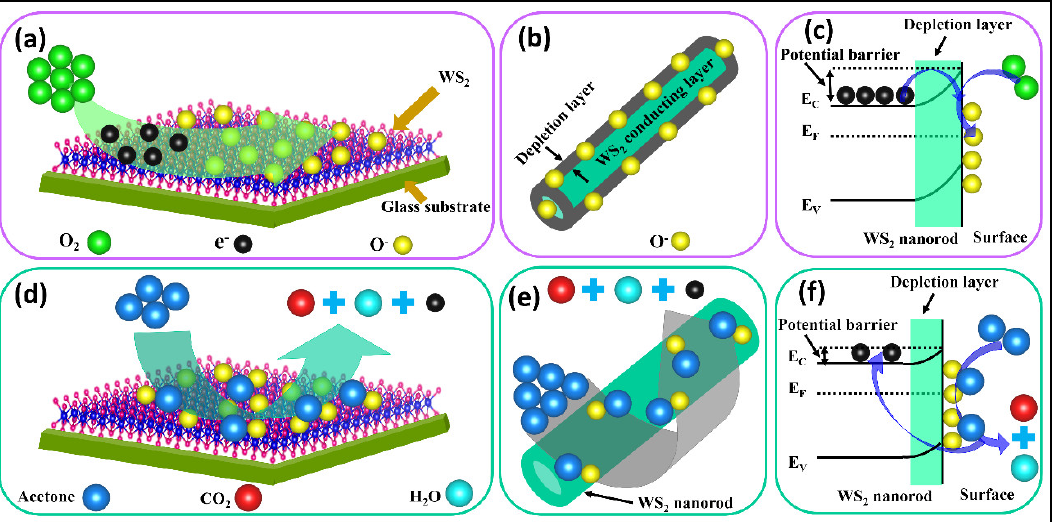
Figure 8. WS 2 nanorod sensor: ( a , d ) Graphical illustration of adsorption of oxygen via electron interactions, formation of the active sites on the surface, and interaction of active sites with the acetone molecules; ( b , e ) visualization of a depletion layer formation around the WS 2 nanorod by adsorbed active sites, and acetone-sensing reaction mechanism; ( c , f ) electronic band structure during active site formation and chemisorption of acetone molecules of the WS 2 nanorod